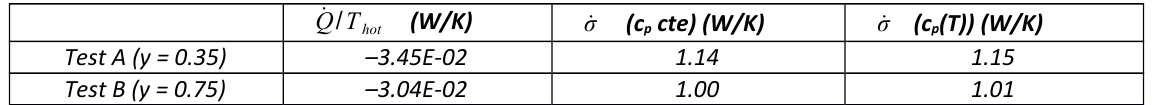
Table 5. Thermal entropy flow and rate of entropy